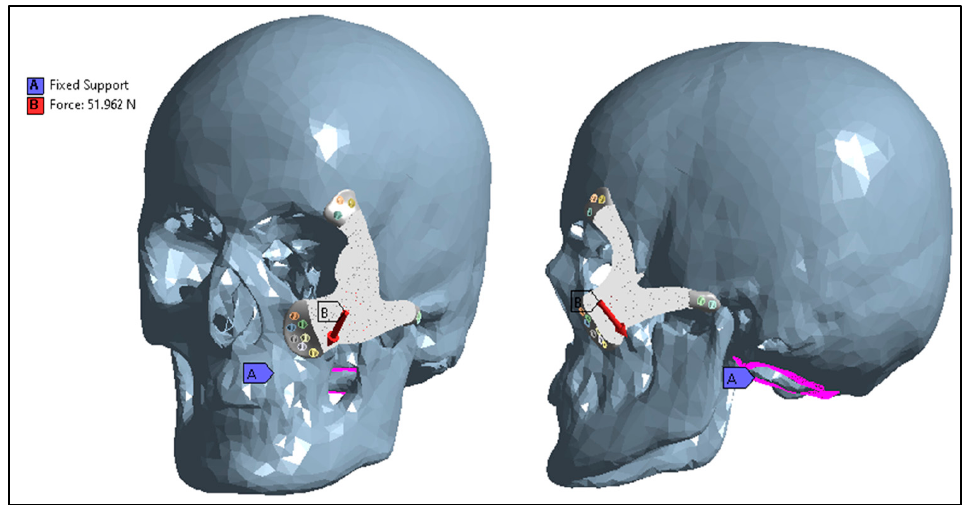
Figure 10. Boundary conditions and external loads applied to the FEM.